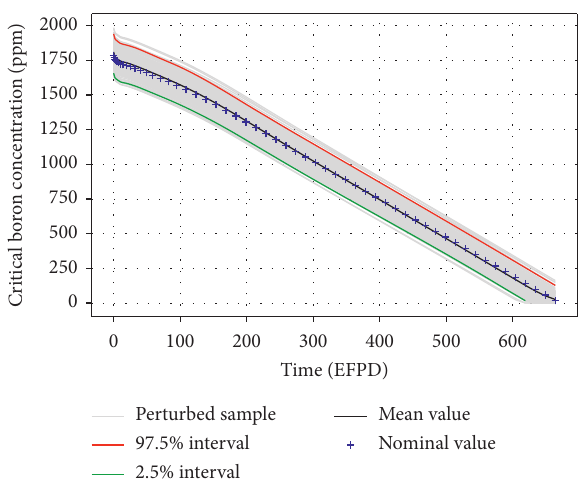
Figure 19: Critical boron concentration of unperturbed and perturbed cases. Figure